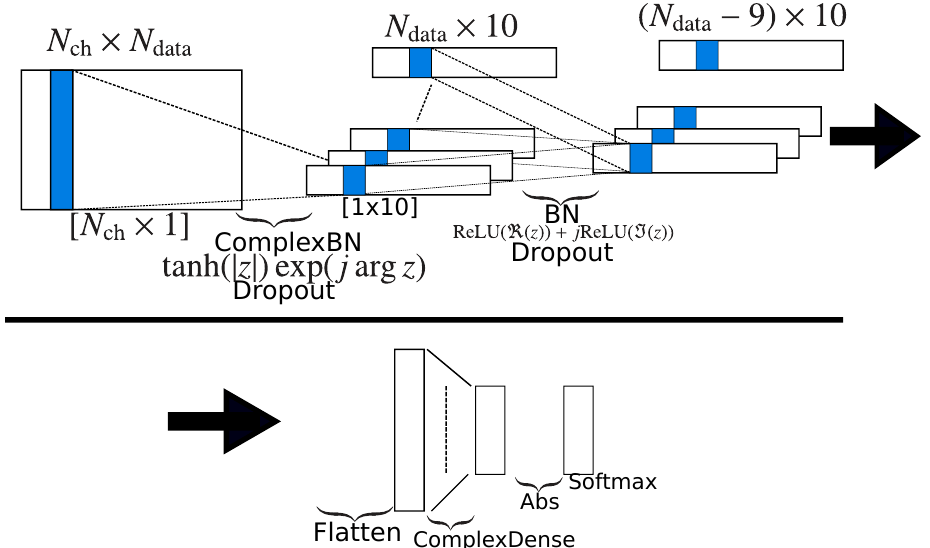
Figure 1. Network structure of the proposed CNN: the first layer is the complex weighted averaging for channels (2–4 in Table 1). The second layer is the filtering for time index (5–8 in Table 1). Then, the data are flattened and goes through the complex dense layer with the absolute activation function. Finally, the output is given by the softmax